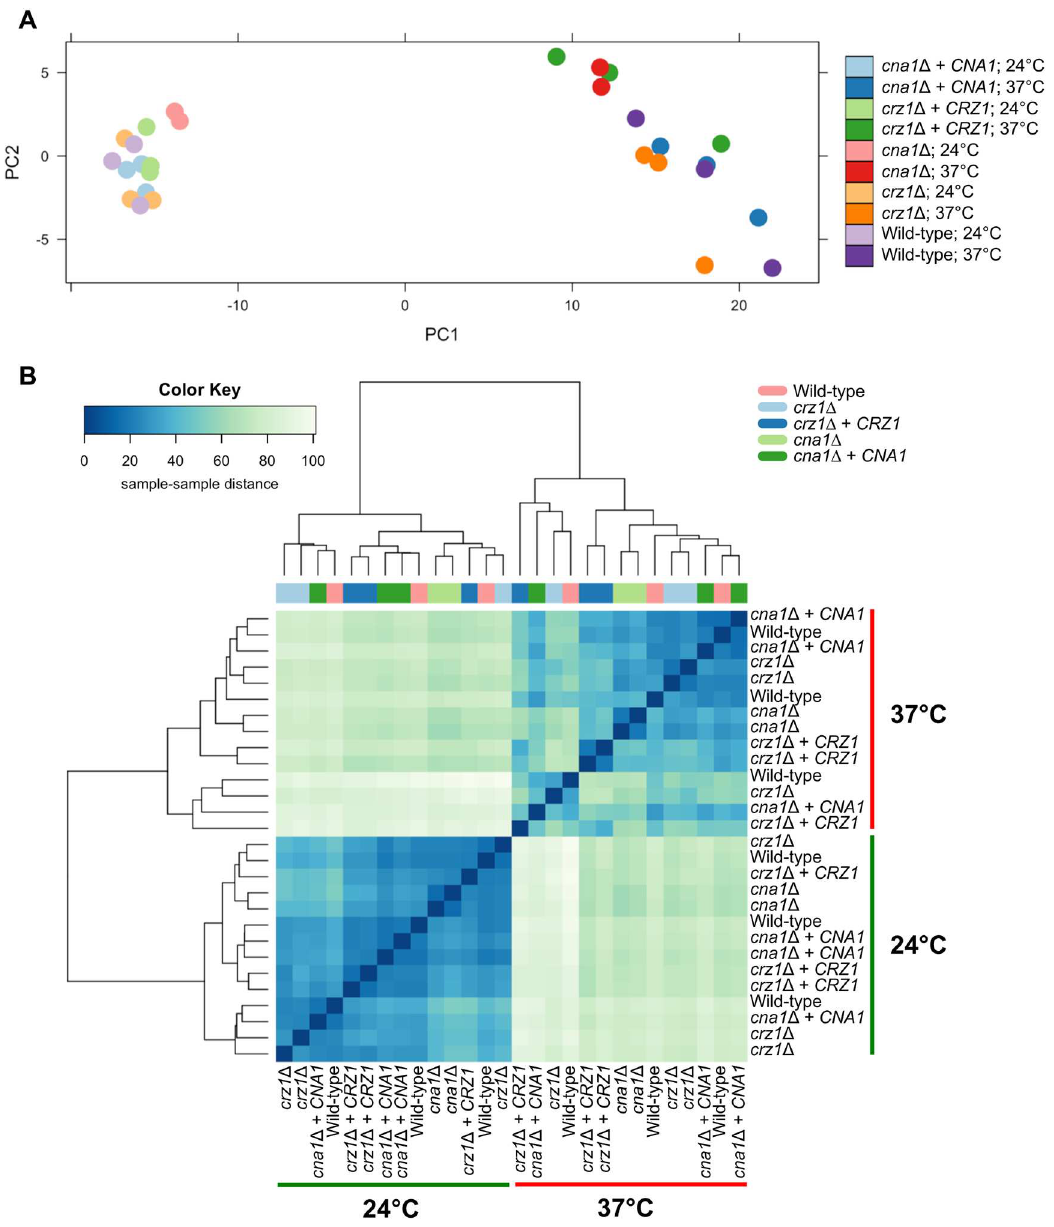
Fig 3. Expression dynamics of calcineurin and Crz1 target genes. (A) Principalcomponentanalysis(PCA) was performed to comparegene expressionlevels of the WT (H99), cna1 Δ (KK1), cna1 Δ + CNA1 (KK5), crz1 Δ (AFA3-3), and crz1 Δ + CRZ1 (AFA3-3-17) strains grown at 24˚C and 37˚C. Lighter colors indicate the 24˚C samples and the bright colors indicatethe 37˚C samples. Note that results for one cna1 Δ 37˚C biologicalreplicatewere not includedin the analysis,due to samplecontamination. (B) Hierarchicalcluster analysisrecapitulates the observation from the PCA. The heatmap indicates the pairwisedistancebetweensamples.The x-axis of the color key indicatesthe distances betweenthe samples, with the darker blue signifyinga highersimilarity(i.e. small distance)betweenthe samples,whilethe lighterblue signifiesa lower similarity(i.e largerdistance)betweenthe samples.The color bar abovethe heatmapindicates the sampletype. Gene expression levelsat 24˚C were differentfrom the geneexpression levelsat 37˚C. In general,geneexpression of samplesgrownat 24˚C showedless variability (dark blue). However, geneexpressionof samplesgrownat 37˚C showed more variability (light